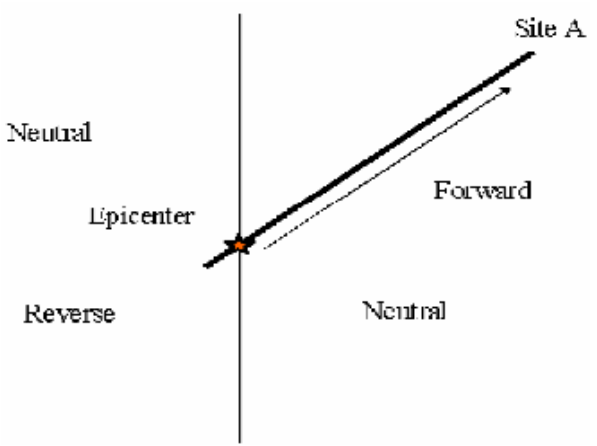
Figure 1. Zones of directivity (Somerville, 2000) Fig. 1. Zones of directivity (Somerville,